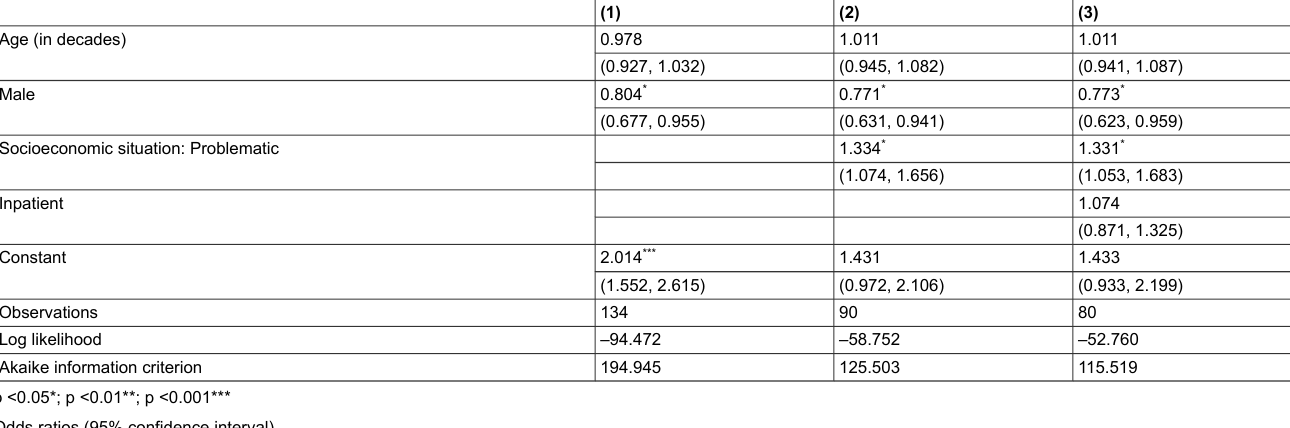
Table 5: Logistic regressions on the response : “Number of past hospitalisations = 4 or